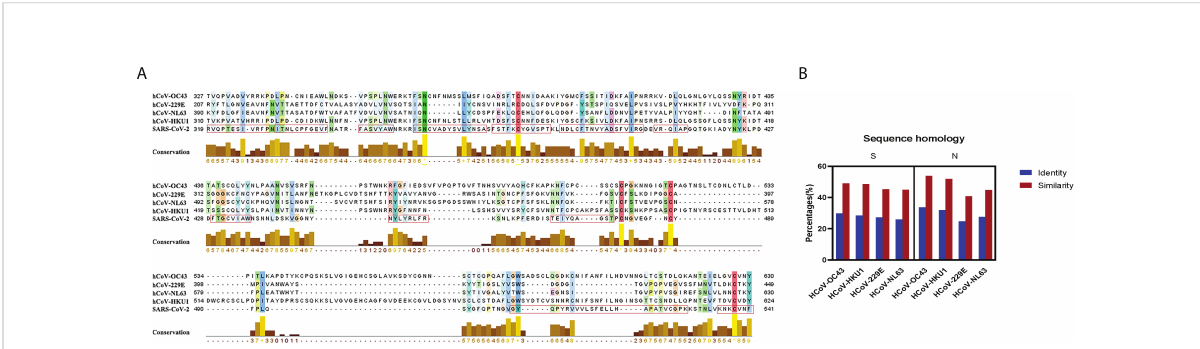
FIGURE 1 Sequence homology and conservation between SARS-CoV-2 and seasonal HCoVs. (A) The conservation and the antigenic epitopes of RBD are shown as a yellow bar chart and a red rectangle. The amino acid conservation scores were classi fi ed into 10 levels (1, most variable; +, most conserved). (B) Sequence homology and conservation of spike protein and nucleoprotein between SARS-CoV-2 and seasonal HCoVs. The identity and the similarity (%) of these two proteins were aligned and analyzed by the BLOSUM50 method of MatGAT (version 2.0) (James and Campanella*,